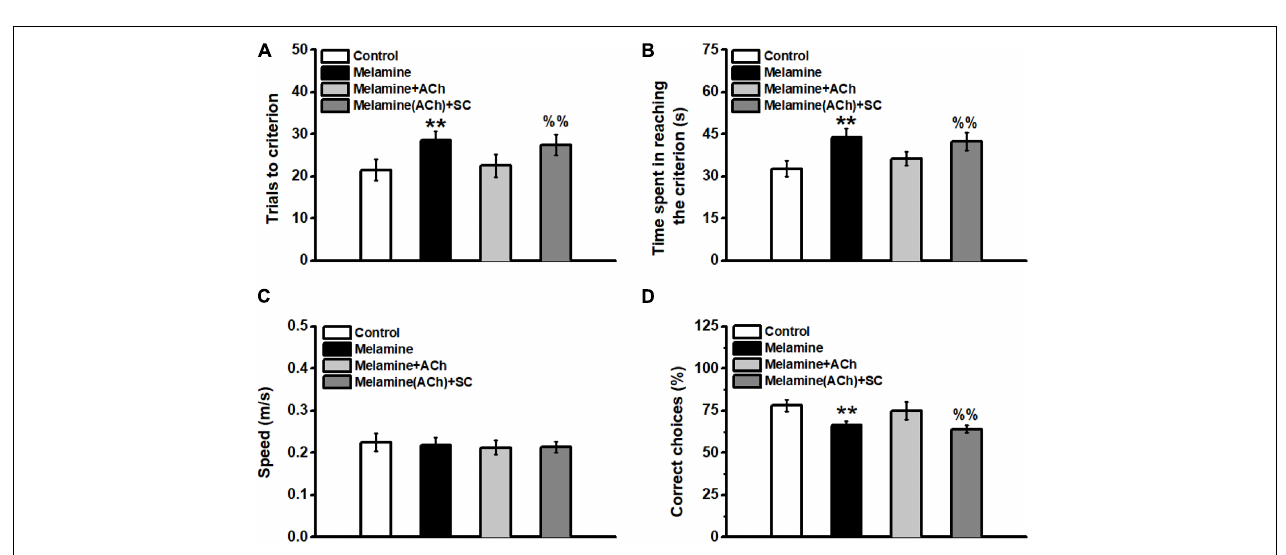
FIGURE 4 | Directional coupling index d and c 2 in the CA3–CA1 pathway. (A) Coupling direction index d between CA1 and CA3. CA3 predominantly drives CA1 in the case of d > 0. (B) Unidirectional influence index c 2 indicating unidirectional neural information flow (NIF) from CA3 to the CA1 area. Both indexes d and c 2 were decreased, but could be reversed by intrahippocampal infusion of acetylcholine (ACh). * P < 0.05, melamine vs. control, melamine+ACh, and control cage; # P < 0.05, melamine(ACh)+SC vs. control, melamine+ACh, and control cage; % P < 0.05, control cage vs. other groups.